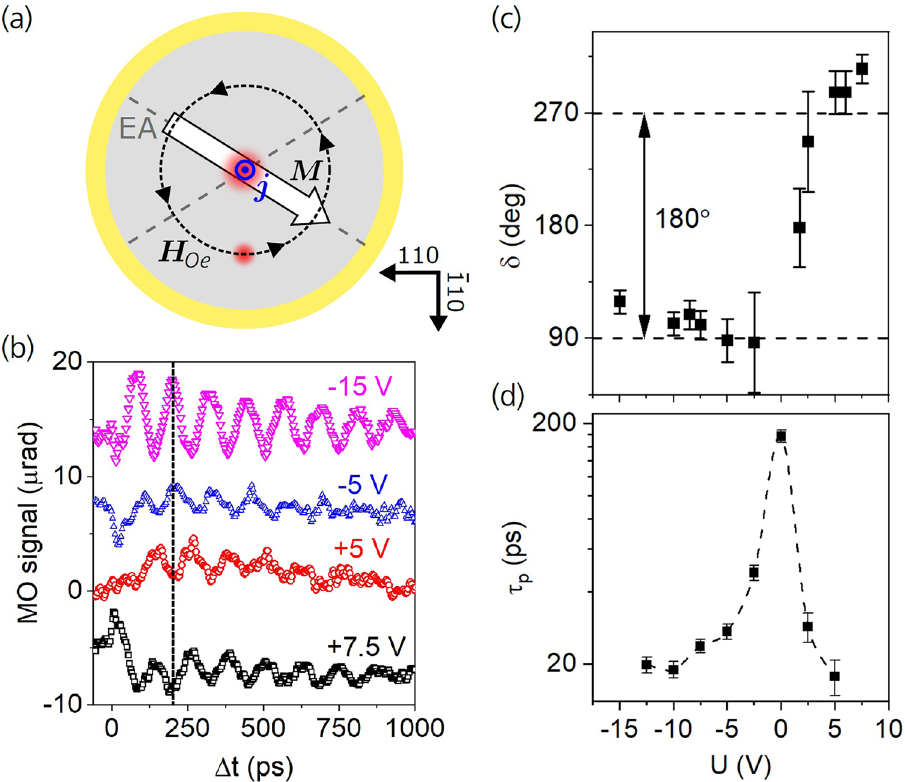
Figure 4. Magnetization precession generated by Oersted field pulses. ( a ) Schematic illustration of the Oersted magnetic field H Oe (black circle) induced in the iron film by the vertically propagating current pulse, which is flowing in the pump-illuminated column, with a diameter of ≈ 1 µm, in the photodiode center (larger red circle). Switching the bias polarity reverses the photocurrent and, consequently, the corresponding field H Oe acting on magnetization M within the probe laser spot (smaller red circle), which is displaced by 9 µm away from the pump laser spot along the [ 110 ] crystallographic direction. (b) Magnetization precession induced by H Oe measured for several biases without external magnetic field applied; the curves are vertically shifted for clarity. The phase of oscillations depends on the bias polarity, as indicated by the dashed line. (c) Bias dependence of the precessional phase δ extracted by fitting the data in part ( b ) by Eq. (1) for Δ t > 100 ps. (d) Bias dependence of the duration of the vertically propagating photocurrent pulse measured by the photocurrent correlation technique. For larger bias magnitudes the photocurrent pulses become considerably shorter than the magnetization precession period, which is the cause of the gradual phase shift of the precession signal observed in ( c